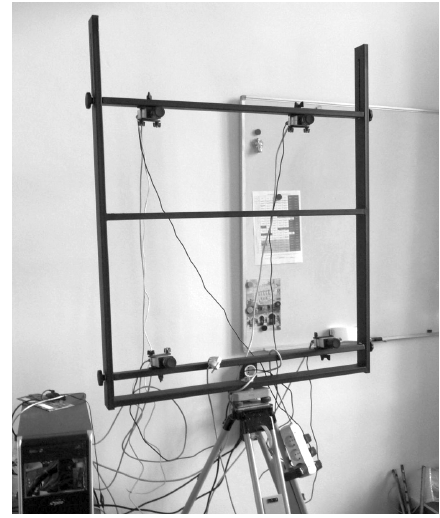
Figure 5. Adjustable camera mount